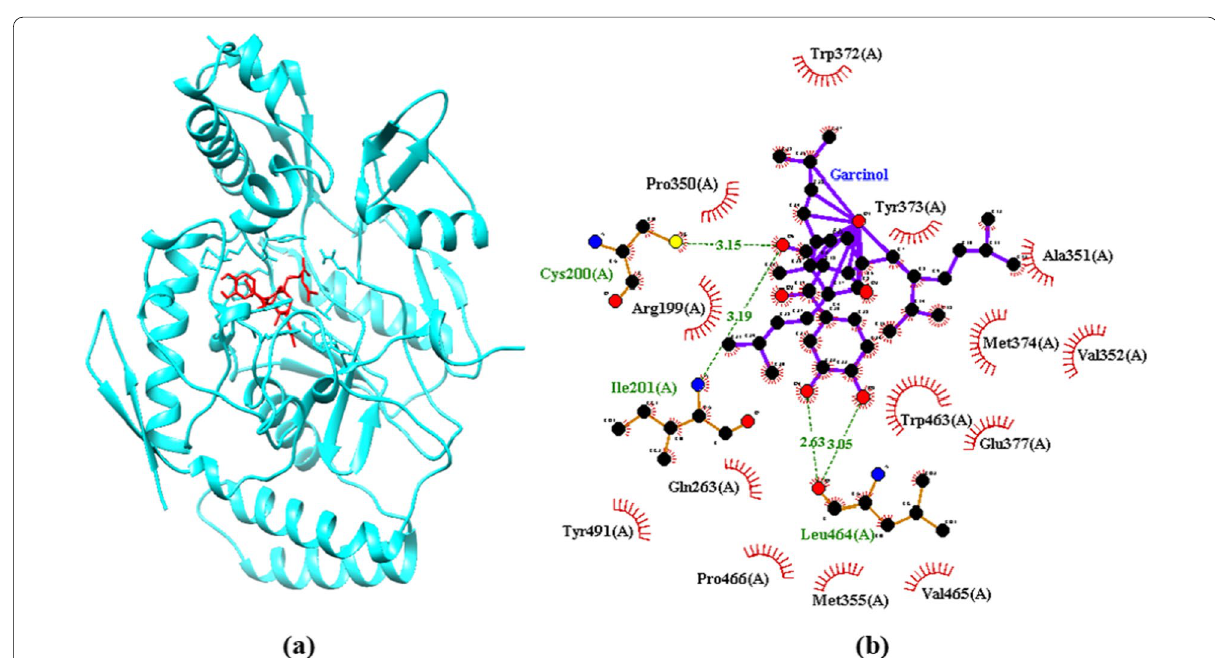
Fig. 9 Docking images of protein (iNOS) and ligand (Garcinol). a Shows the 3D interaction between garcinol (red) and iNOS (blue). b LigPlot image showing the H-bond interactions (Cys200, Ile201, Leu464) and hydrophobic interactions (Arg199, Gln263, Trp372, Pro350, Tyr373, + Ala351, Met374, Val352, Trp463, Glu377, Val465, Met355, Pro466, Tyr491) between Garcinol and COX-2